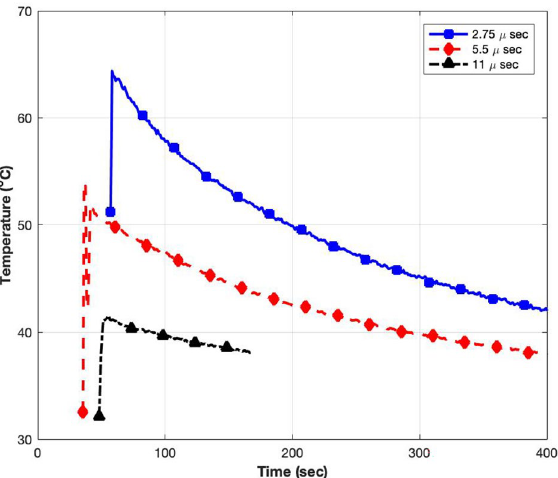
Figure 14. Measurements of media temperature immediately after 18 min exposures, at interpulse intervals of 2.75, 5.5 and 11 μs.